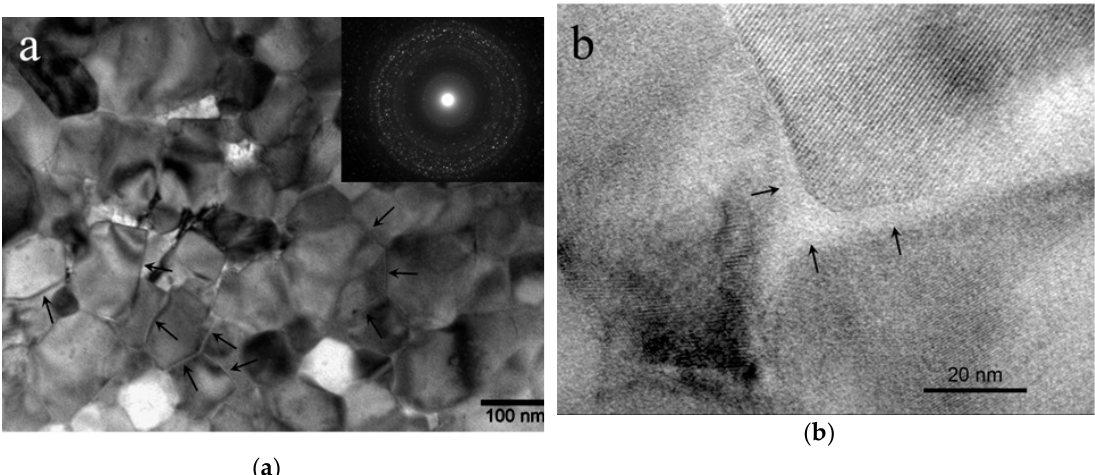
Figure 4. Bright field image of the microstructure with diffraction ( a ) and a high resolution ( b ) image (Nd-rich phase marked with arrows) of the SG1 sample after annealing at 625 °C for 30 min.